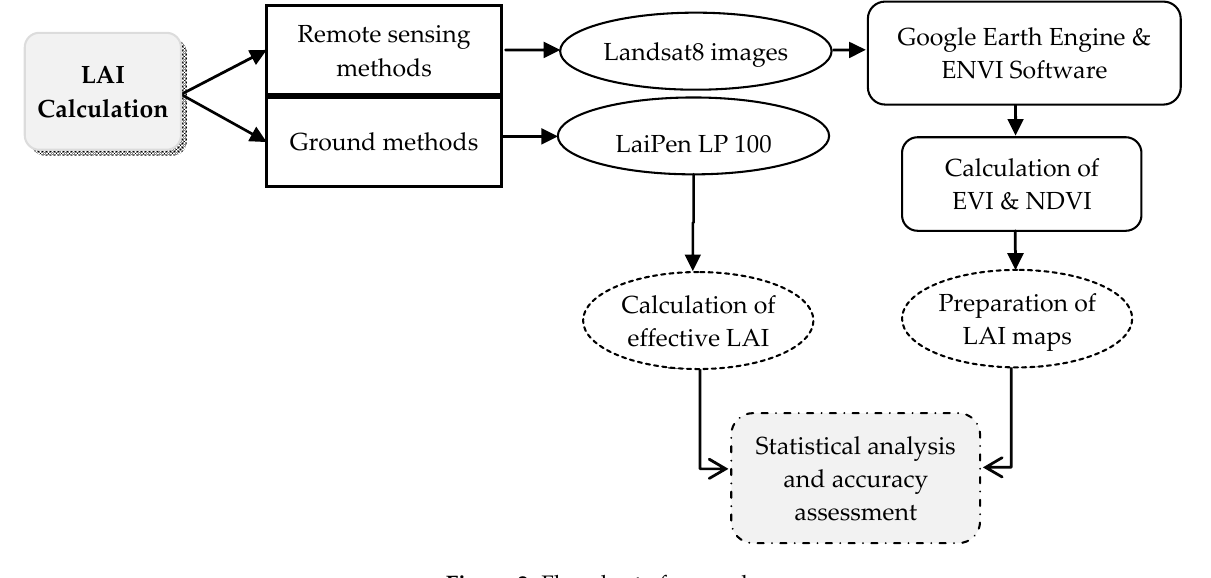
Figure 2. Flowchart of research. Table 3. Specifications of Landsat 8 satellite images used in the present